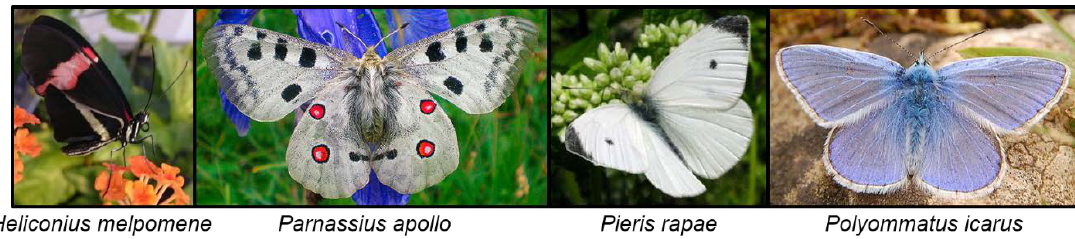
Figure 15. Various butterfly species. H. melpomene photo by Érika Cristina Pinheiro de Castro, P. apollo photo by Hinox (https://commons.wikimedia.org/wiki/File:Parnassius_apollo_Pirineus.JPG), P. rapae photo by David Hanson (http://www.neotropicalbutterflies.com/Site%20Revision/Pages/ PieridPages/Pieris_rapae.html), P. icarus photo by Luc Viatour (https://commons.wikimedia.org/ wiki/File:Butterfly_Luc_Viatour.JPG).